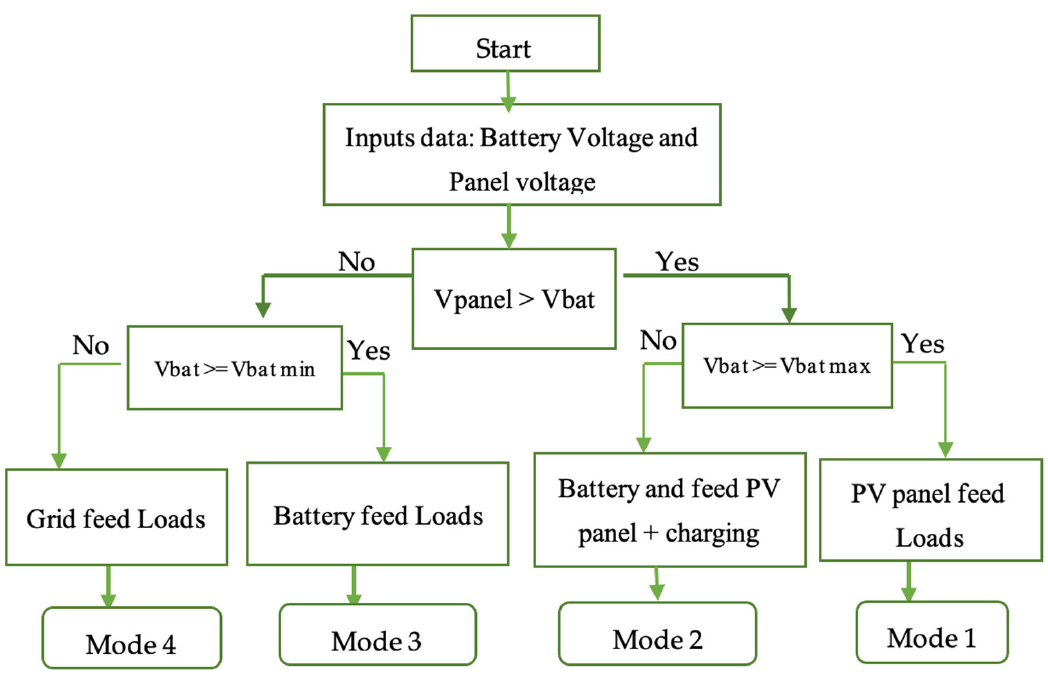
Figure 4. Flowchart of the Energy Management Strategy. Table 1 . Energy Flow Management Operating Modes.